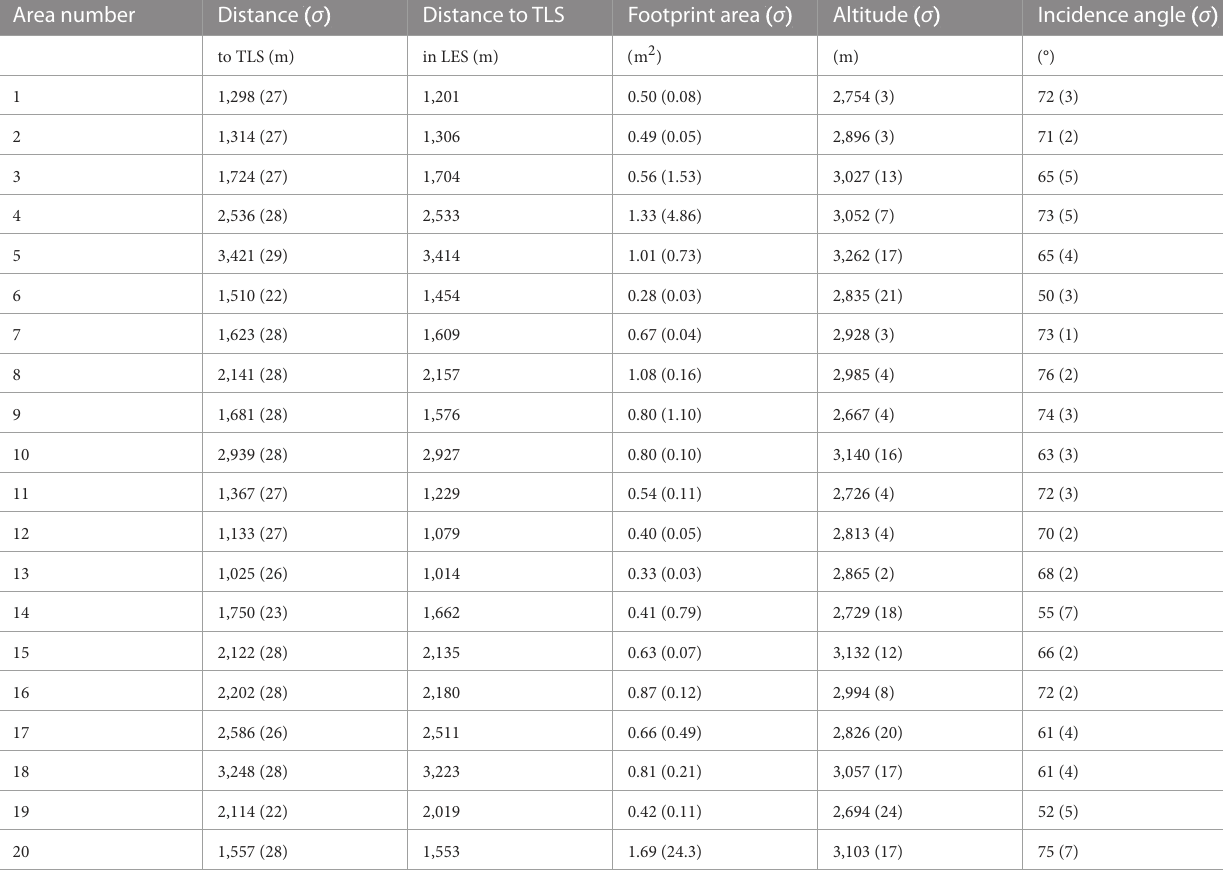
TABLE2 MeandistancetotheTLSasmeasuredbytheTLSandasusedintheLES,meanfootprintareas,meanaltitudeabovethesealevel,andmeanincidence anglewithstandarddeviations σ oftheareasdenotedinFigure 1.